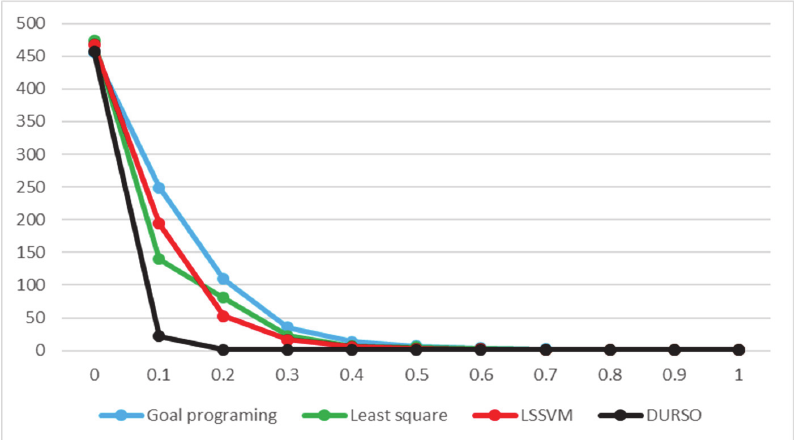
Fig. 4. Performance (ARL) of methods under shifts in